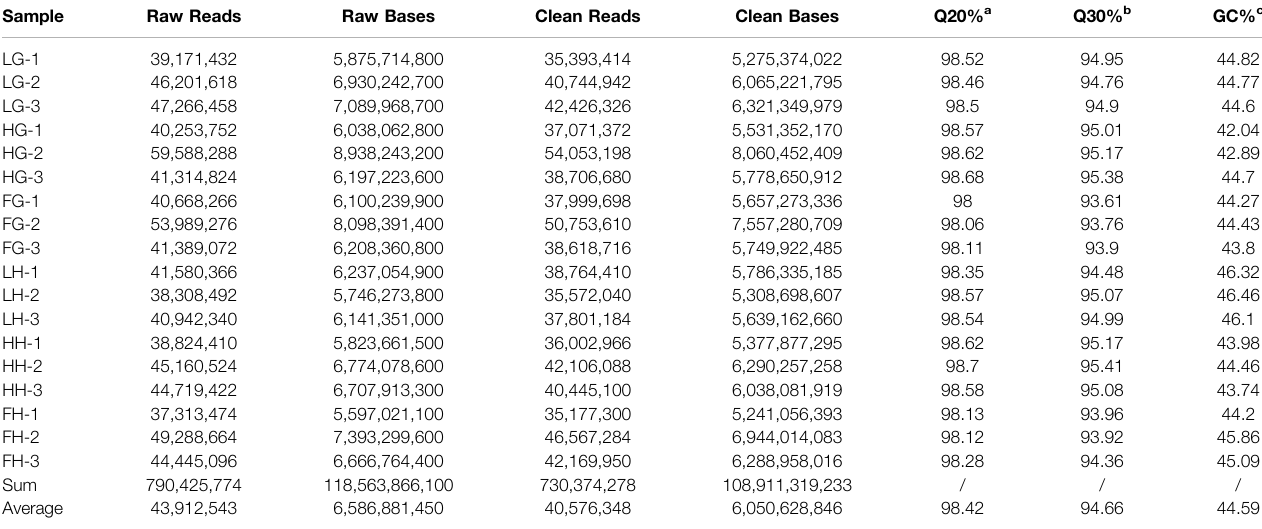
TABLE 2 | Basic statistics of RNA-seq reads in M. nipponense .